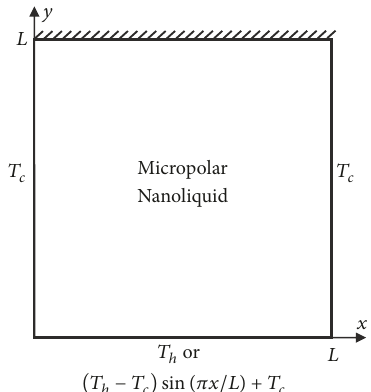
Figure 1: Schematic representation of the